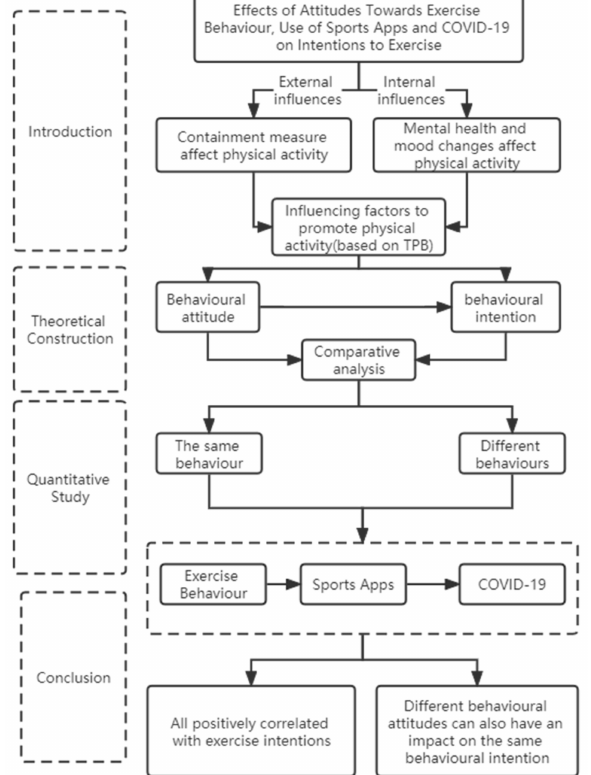
Figure 1. Flow chart of the research